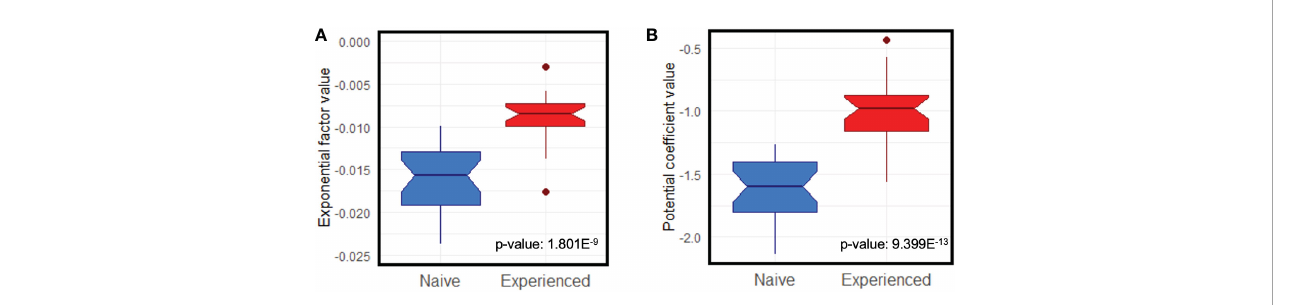
TABLE 2 Parameters of interest of the breakthrough infection cases detected during our study.